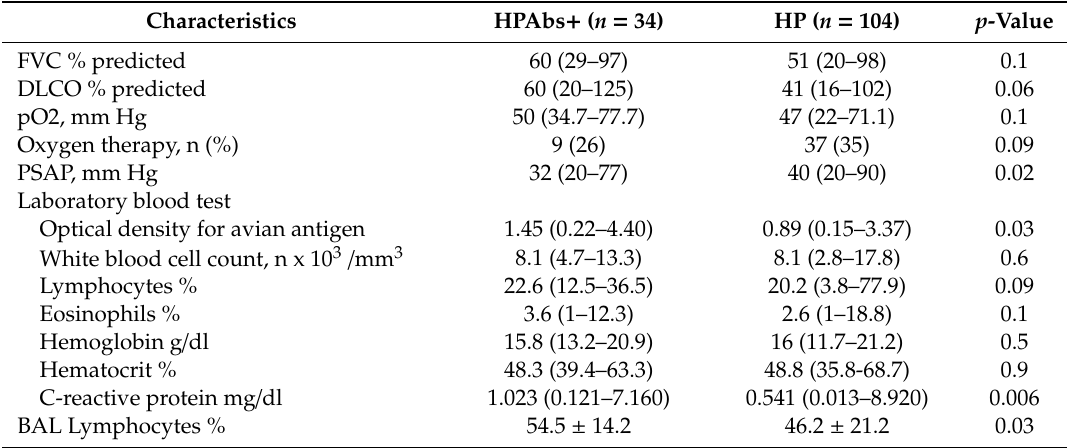
Table 3. Assessment of lung function and main laboratory findings in HP patients.